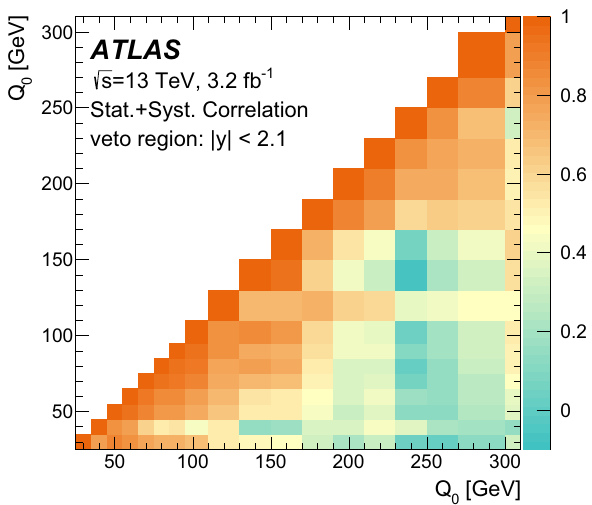
Fig. 12 The correlation matrix (including statistical and systematic correlations) for the gap fraction measurement at different values of Q 0 for the full central rapidity region | y | < 2 . 1